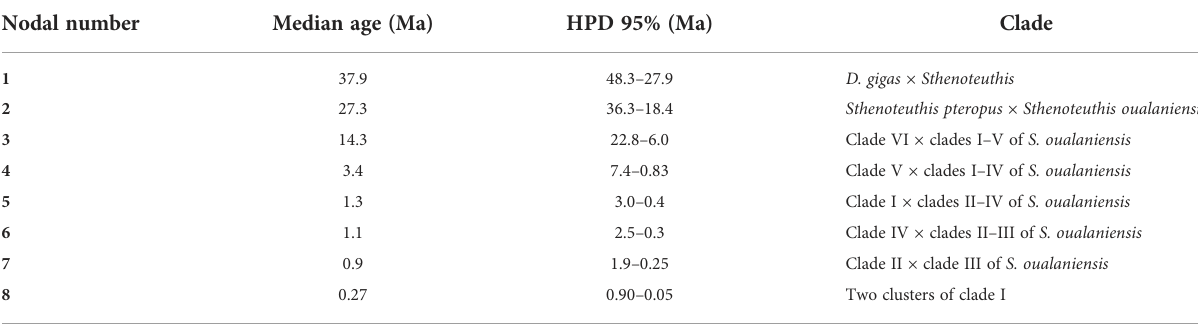
Nodal number is same as that in Figure 2. HPD, highest posterior density.